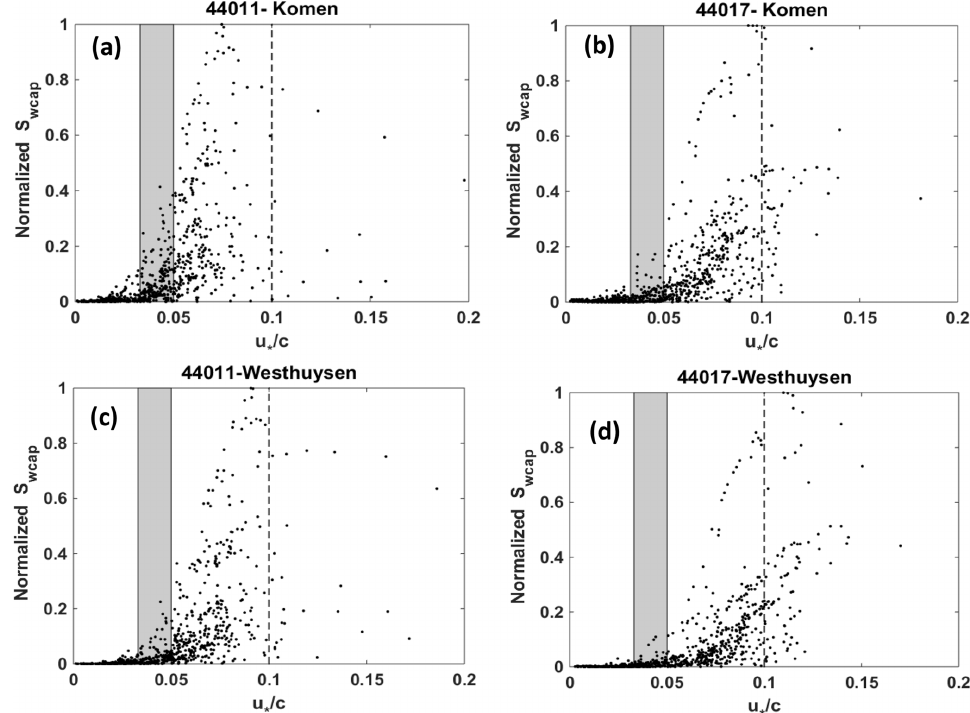
Figure 13. Variations of the normalized whitecapping dissipation ( S wcap ) from Komen and Westhuysen simulation scenarios with the inverse wave age u ∗ at (a , c) NDBC 44011 and (b , d) NDBC 44017. Gray boxes indicate the fully developed zone (0 . 033 < u ∗ c line separates zones for linear and quadratic growth based on Yan (198y) as indicated by u ∗